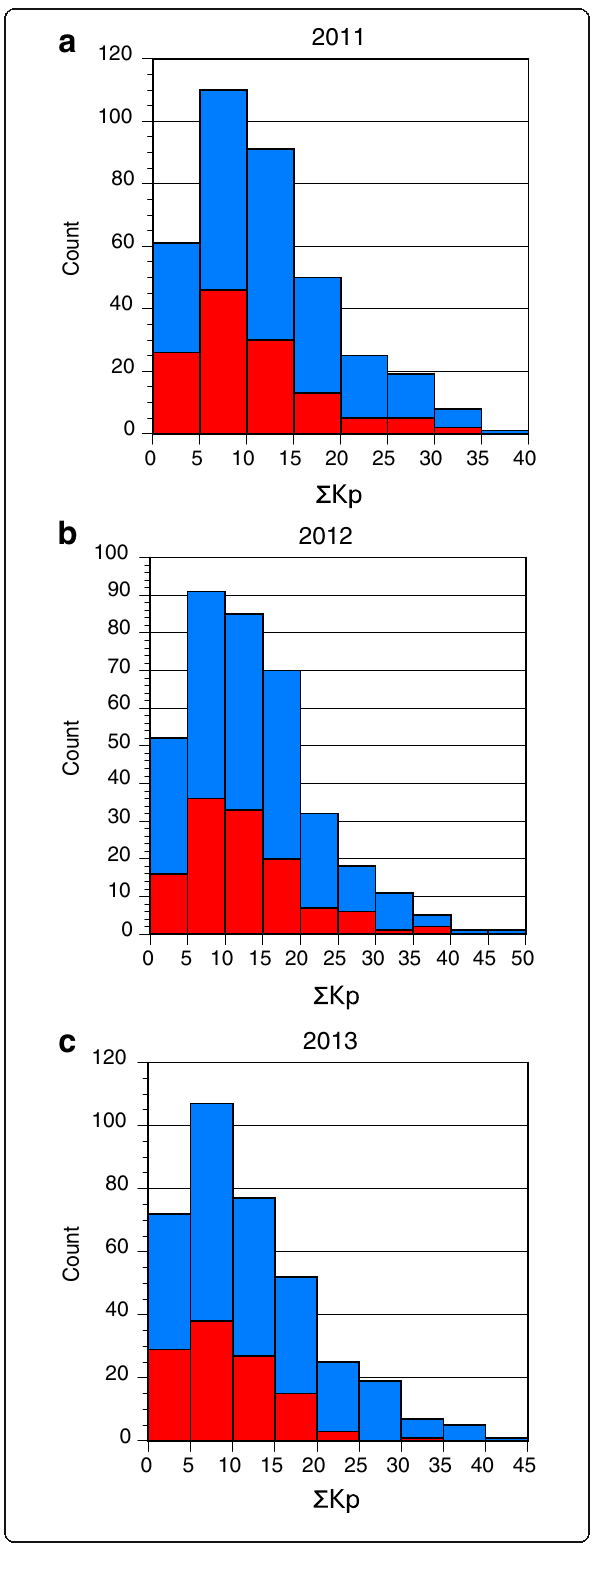
Fig. 8 Histograms of the number of EPB occurrence/non-occurrence days for Σ Kp . The histograms indicate the relationship between Σ Kp (daily total of the Kp ) and the number of days of EPB occurrence (red bars) and non-occurrence (blue bars) in a 2011, b 2012, and c